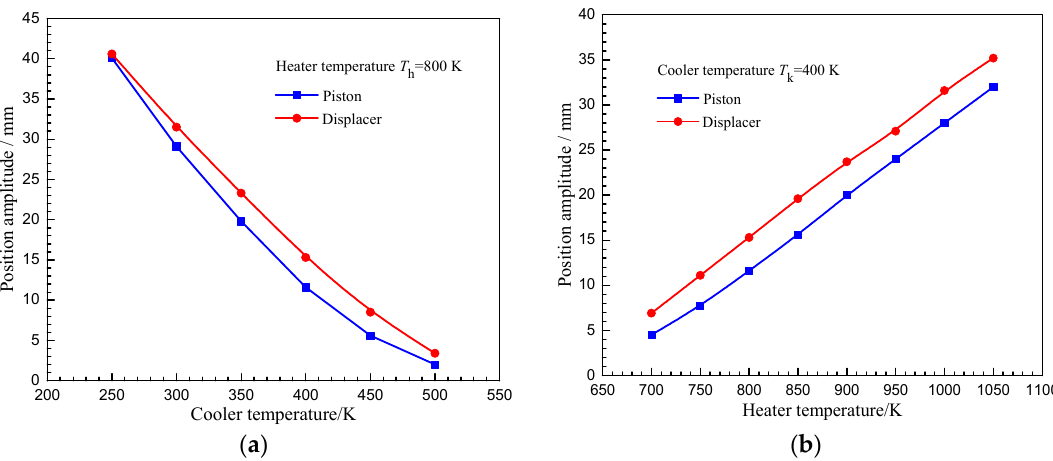
Figure 12. Effect on position amplitude of piston and displacer: ( a ) effect of cooler temperature, ( b ) effect of heater temperature.